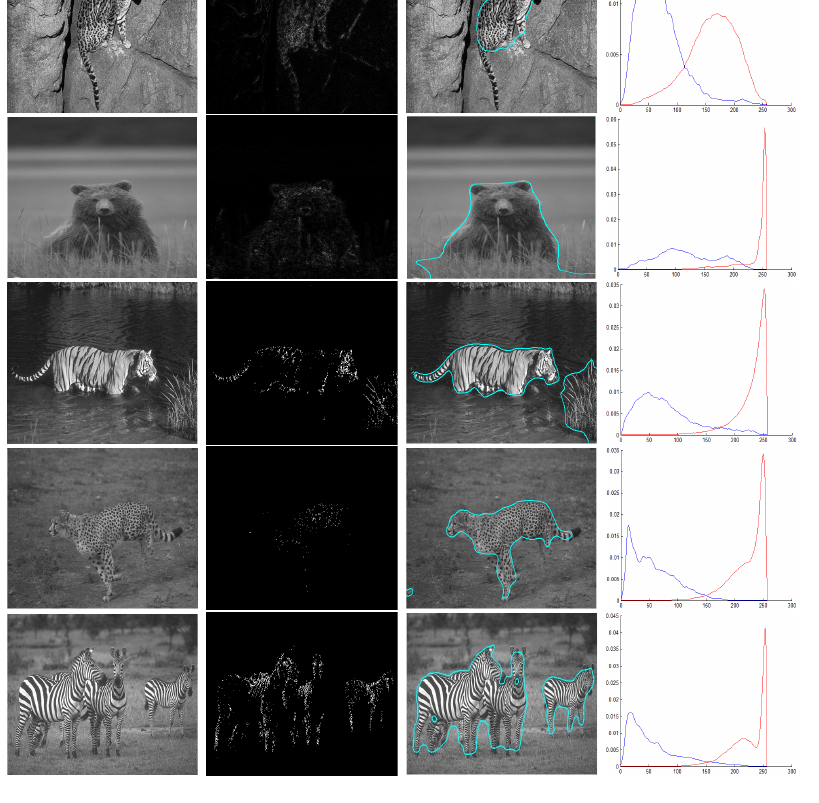
Figure 2. Left column: Real images which presents textured features. Column two: results of our descriptor. Column three: our segmentation results. Right column: final inside probability density function (red plot) and final outside probability density function (blue